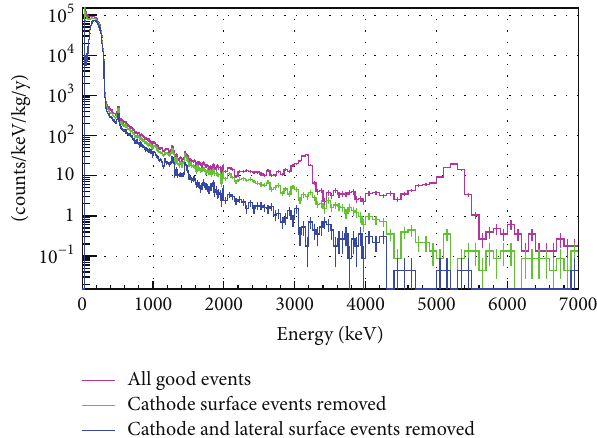
Figure 6: Background rate spectrum before and after removal of surface events.